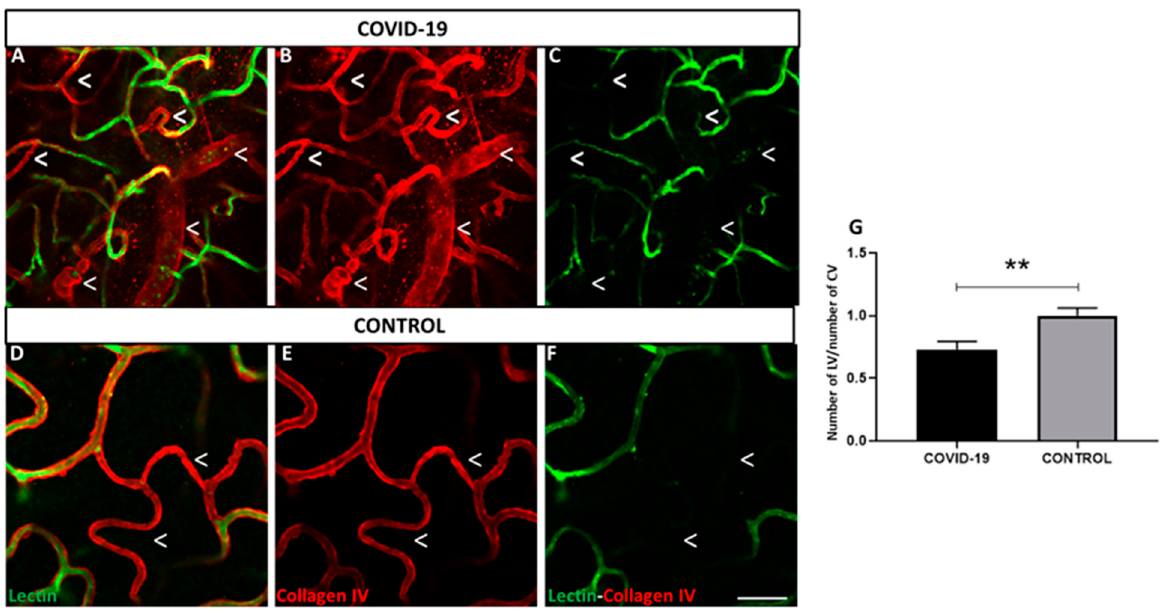
Figure 1. Retinal vessels labeled with lectin vs. collagen IV positive vessels. ( A – F ) Endothelial cells in retinal flat-mounts are labelled with lectin (green) and basement membrane is stained with collagen IV (red) in COVID-19 ( A – C ) and control retinas ( D – F ). ( G ) Percentage of number of lectin vessels (LV) vs. number of collagen IV vessels (CV). Expression of lectin decreased in endothelial cells in both groups; however, COVID-19 retinas showed less expression than controls. ** p < 0.01. Scale bar: 100 µm. Arrowheads indicate missing lectin endothelium areas.